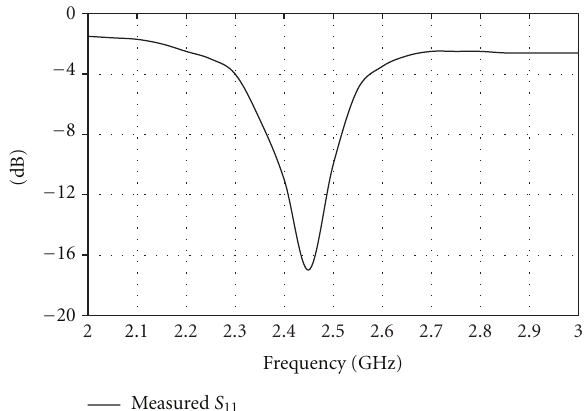
Figure 18: Measured return loss of the dual-beam printed dipole antenna.